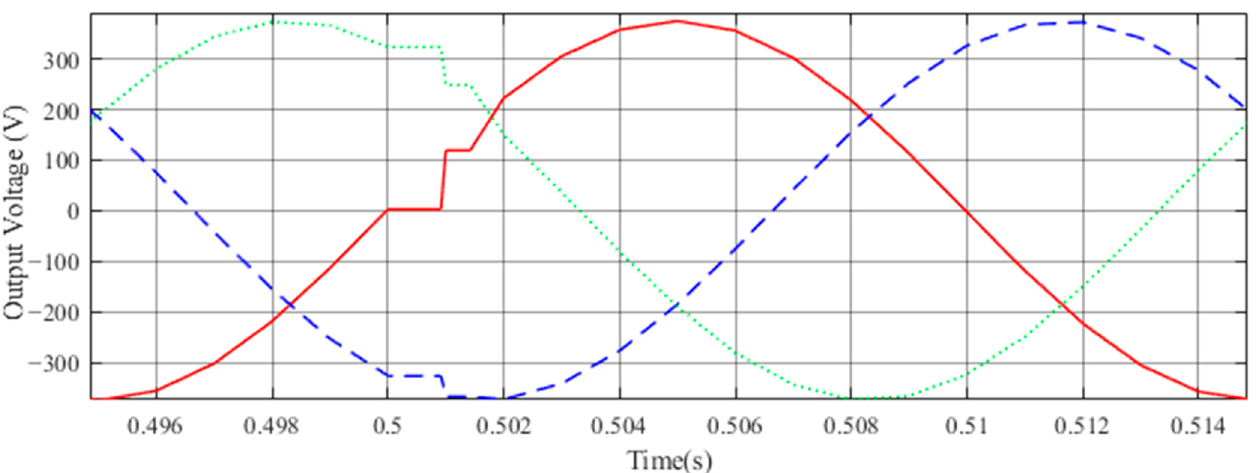
Figure 6. Output voltage zoomed-in view.